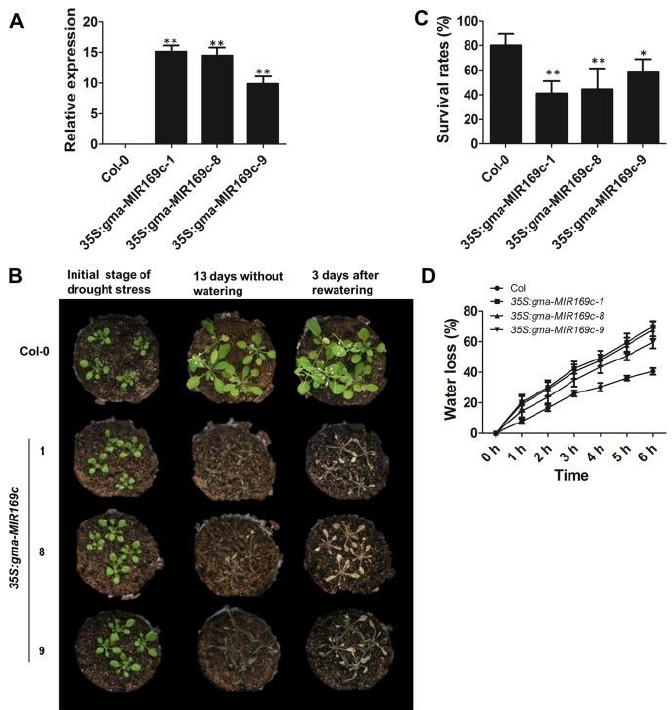
Figure 7. Arabidopsis plants overexpressing the 35S:gma-MIR169c gene show an increased sensitivity to drought stress compared to the wild type * p < 0.05;** p < 0.01 [35].